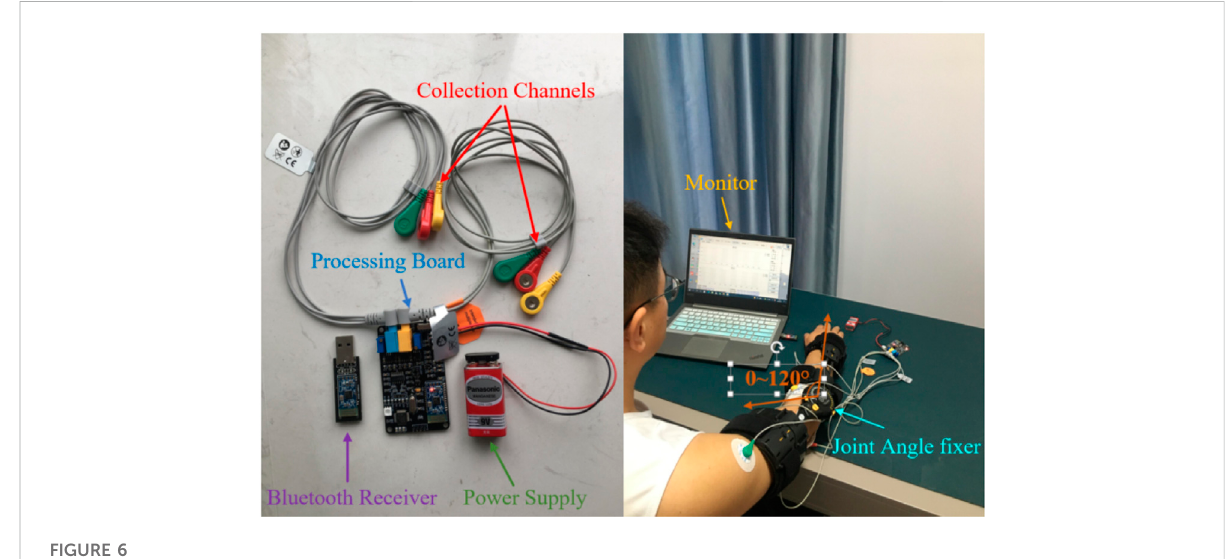
FIGURE 6 The experimental platform.